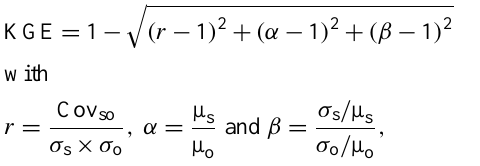
Measured at experimental plots a Parameter calibrated for each soil material with SCEM algorithm and Kling–Gupta efficiency as optimization criterion. b The upper parameter limit of (cid:50) r and the lower parameter limit of (cid:50) s were obtained from the lowest, respectively, highest measured volumetric soil moisture value of each layer in the respective soil moisture plot. c Rainfall at plot SM-2 is estimated by inverse distance weighted interpolation with elevation as additional predictor. d Maximum and minimum daily air temperature at the soil moisture plots is estimated by calculation of an elevation–temperature gradient based on meteorological stations in the Jordan Valley and the